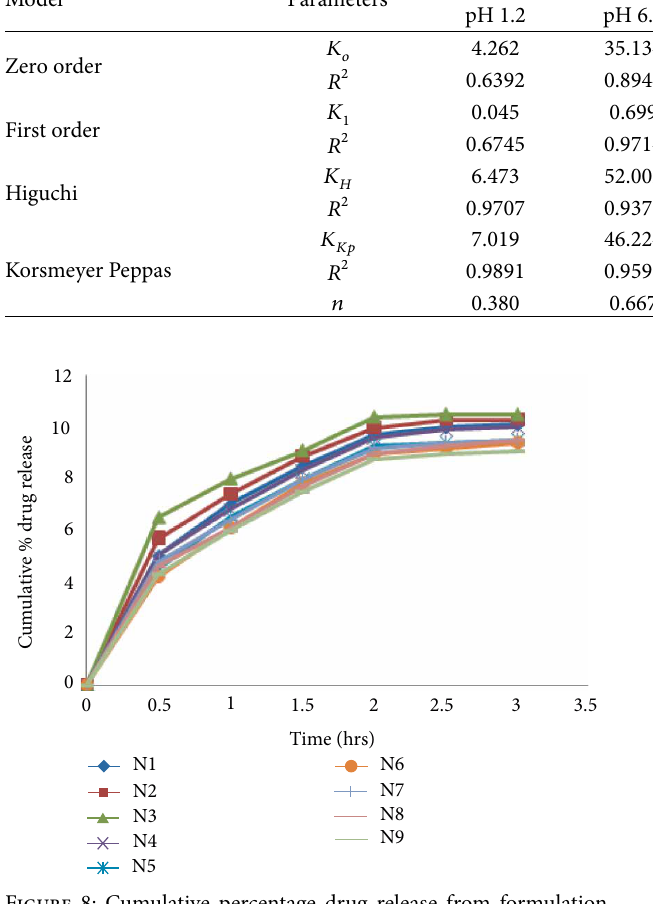
Figure 8: Cumulative percentage drug release from formulation (N1–N9) at pH 1.2.